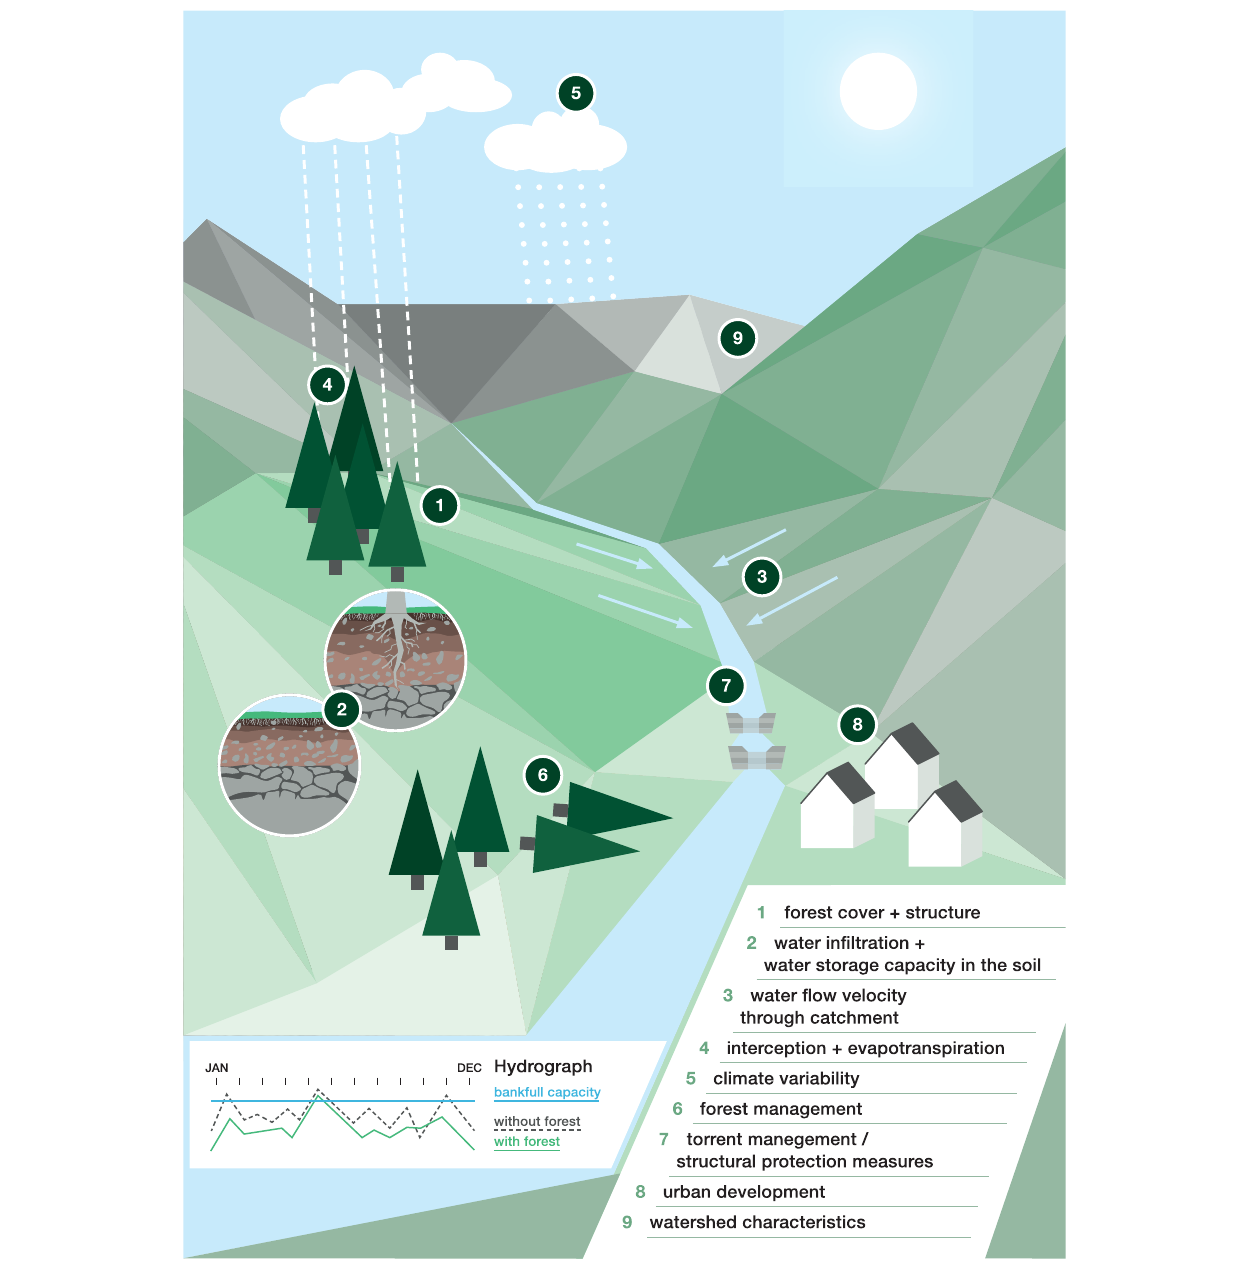
FIGURE 1 | Conceptual representation of the different factors influencing catchment-scale runoff and how they might affect catchment hydrology. The focus is on the effect of forests on catchment